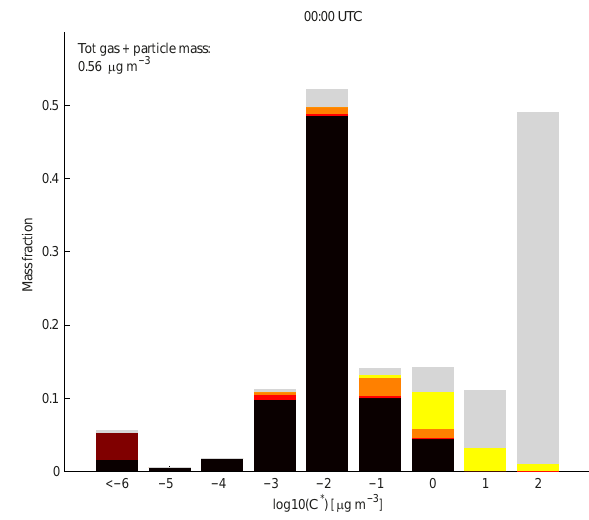
Figure 8. Modeled mean volatility distribution of SOA components at Pallas at 00:00UTC. The gray bars are the sum of all oxidized organic compounds in the gas phase with C ∗ ≤ 10 2 µgm − 3 . The mass in each volatility bin is normalized to the total mass (gas and particle phase) of compounds with C ∗ ≤ 1µgm − 3 . The black, dark red, red, orange and yellow bars are HOM C10, HOM C20, HOM C10–NO 3 , MCM LVOC and MCM SVOC, respectively. The parti- cles are assumed to be liquid and the vapor pressures of the HOMs are estimated with SIMPOL with a temperature of